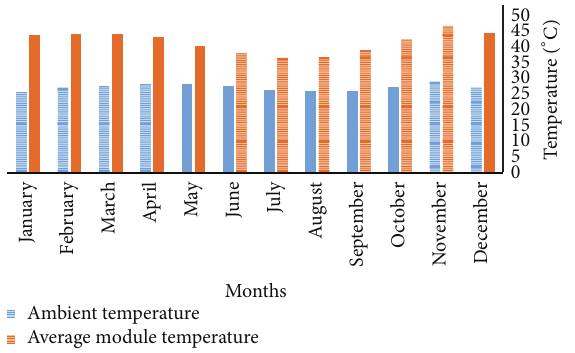
Figure 11: Ambient temperature versus average module tempera- ture.